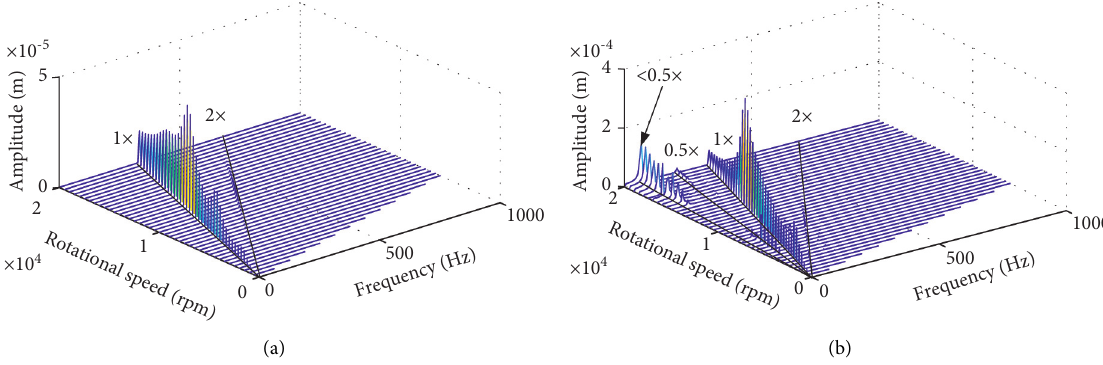
Figure 9: Waterfall diagram of bearing vibration spectrum: (a) normal state, (b) fault